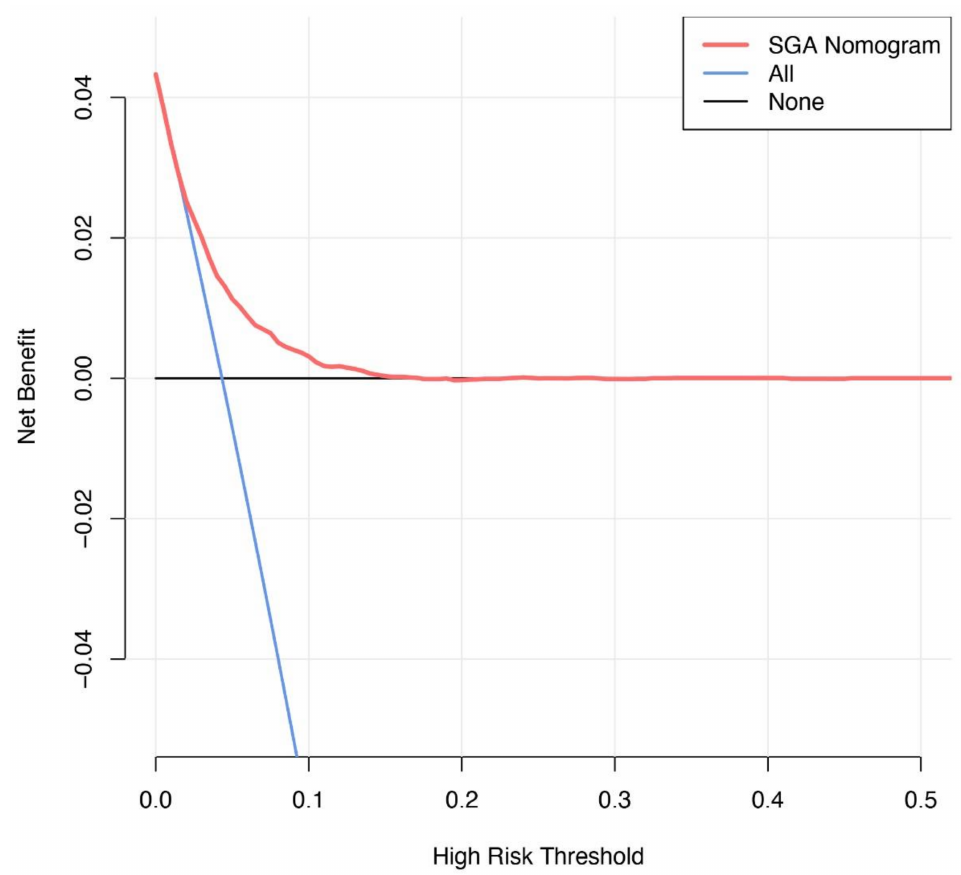
Figure 5. Decision curve analysis for the small for gestational age (SGA) prediction model.